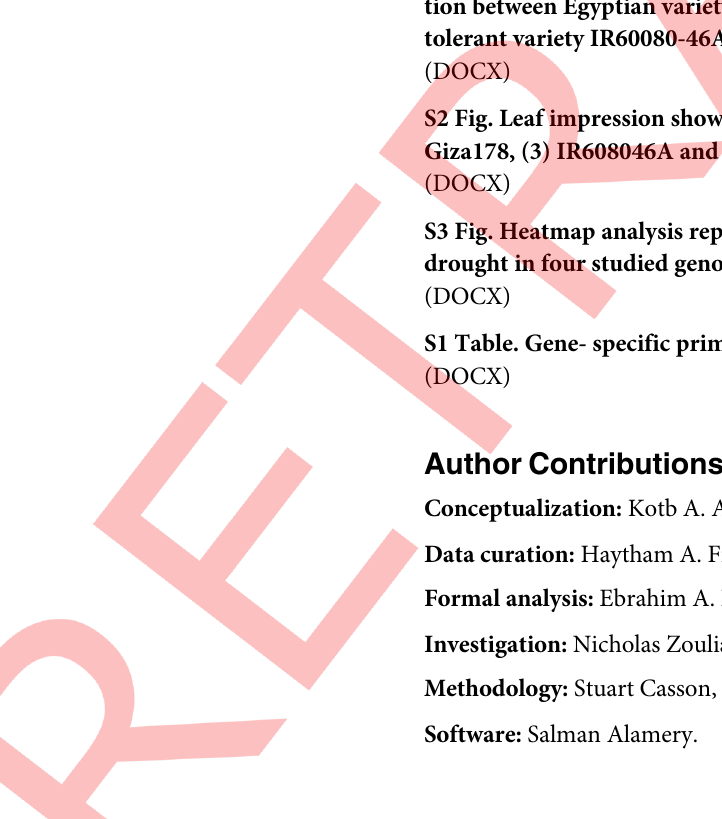
S1 Fig. Diagram for description of candidate line RBL112 drived from back-cross popula- tion between Egyptian variety Giza-178 as a recurrent parent and a Philippines drought- tolerant variety IR60080-46A. S2 Fig. Leaf impression showing stomata distribution on abexial surface of (1) IR64, (2)